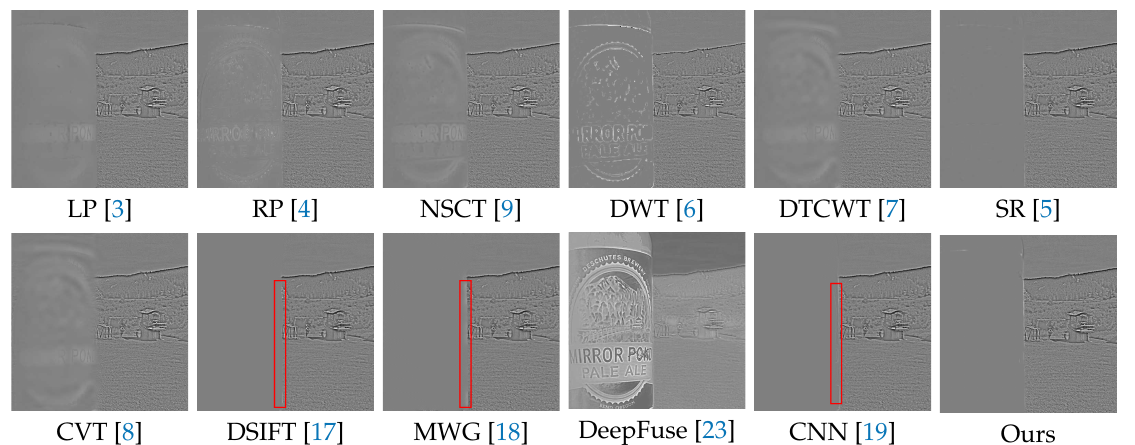
Figure 10. The difference images obtained by subtracting one source image from each fused image (see Figure